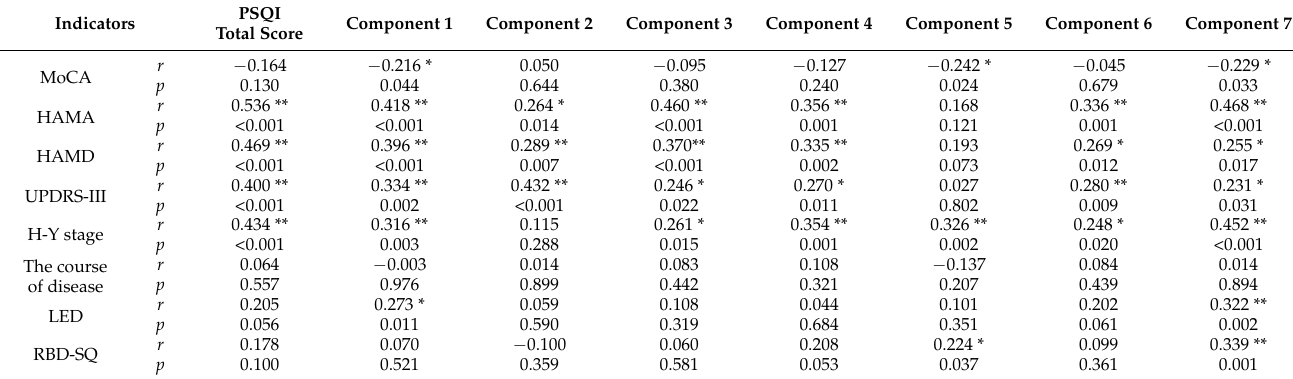
Figure 4. ( a ) HAMA and the PSQI overall score had a positive connection ( r = 0.536, p < 0.001). ( b ) HAMD and the total score of PSQI had a positive connection ( r = 0.469, p < 0.001). ( c ) H-Y stage and the PSQI total score had a positive connection ( r = 0.434, p < 0.001). ( d ) Showed a positive connection between UPDRS-III and PSQI total score ( r = 0.400, p < 0.001). Table 5. Correlation between each clinical index and PSQI scale.